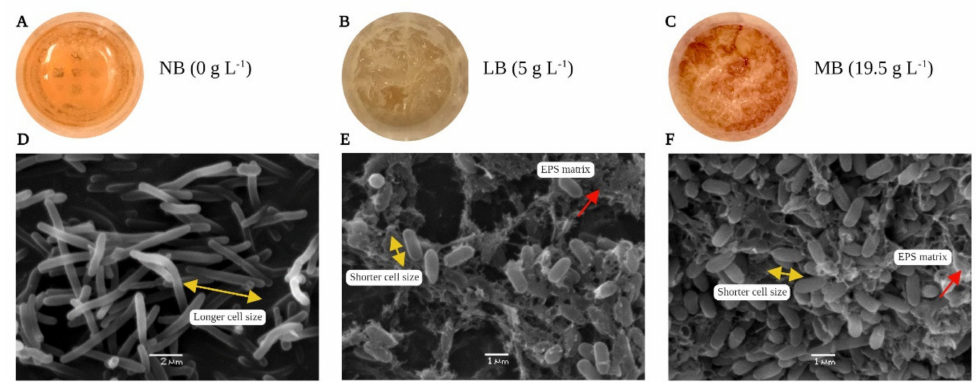
Figure 2. Pellicle formation by B. haynesii CamB6 by at air–liquid interface ( A ) NB medium, ( B ) LB medium, ( C ) MB medium; SEM photomicrographs of pellicles at 10,000 × , ( D ) NB medium, ( E ) LB medium, ( F ) MB